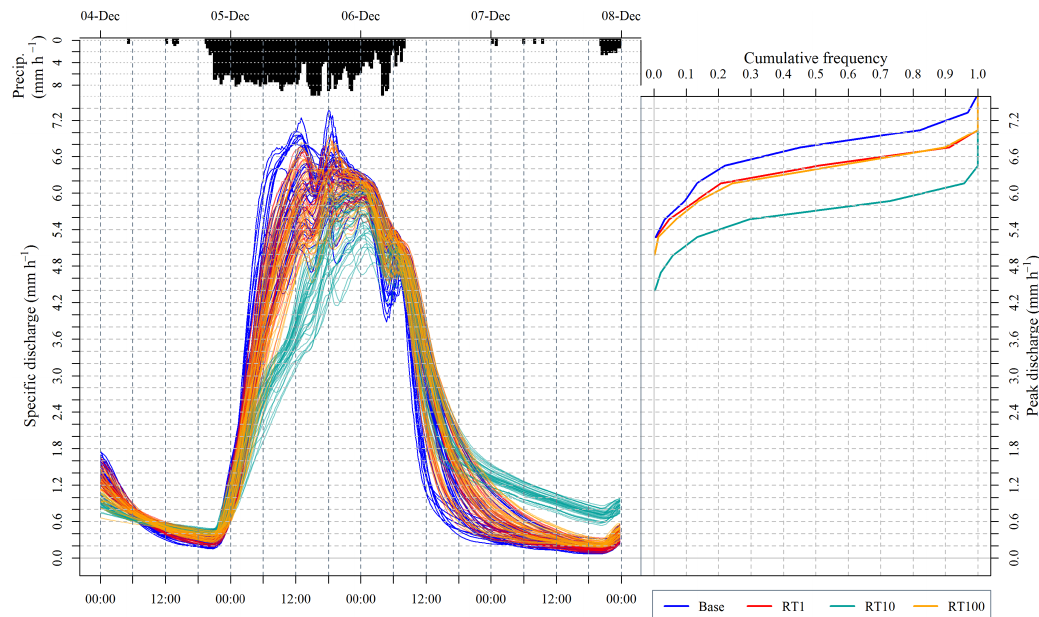
Figure 9. Left: 90th percentile scored baseline and corresponding intervention cases through Storm Desmond. Left: CDF of peak discharges for base and intervention